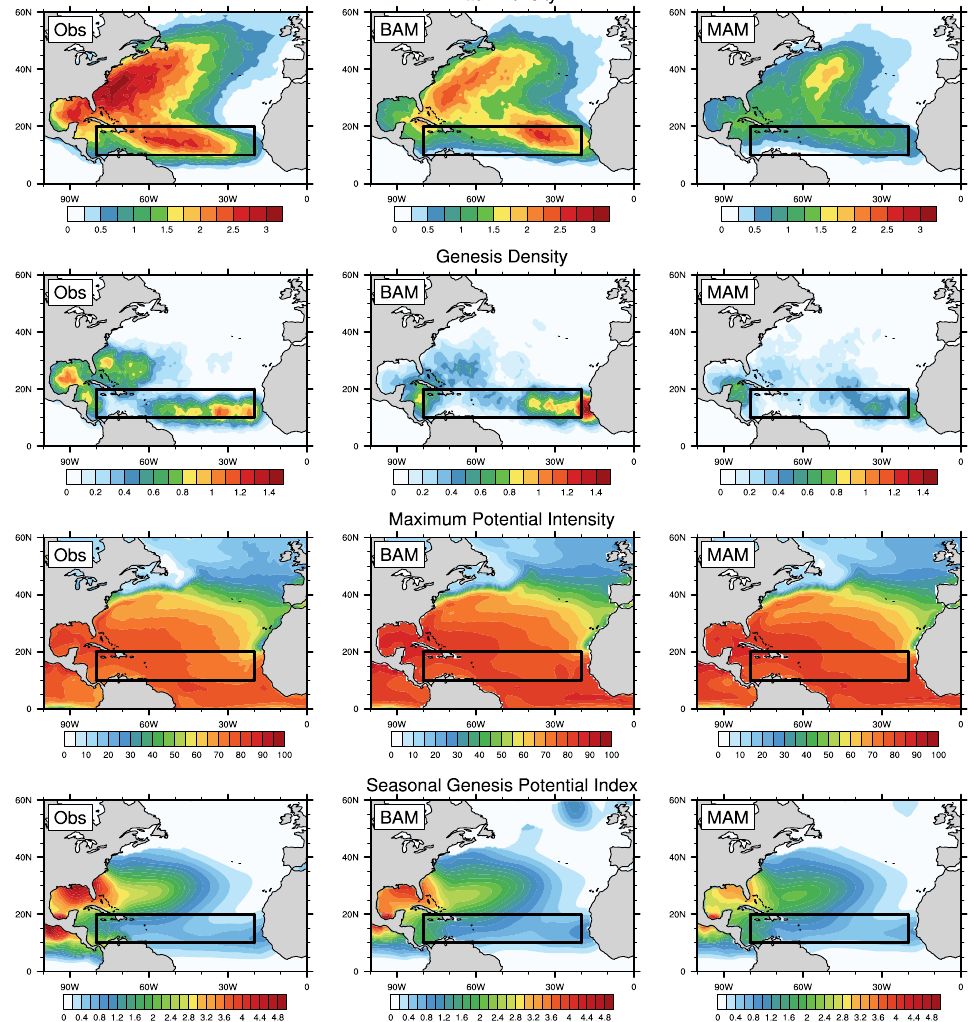
Figure 1. North Atlantic distribution of the ( first row ) seasonal track density, ( second row ) seasonal storm genesis density, ( third row ) seasonal maximum potential intensity (MPI, m/s), and ( fourth row ) seasonal average genesis potential index (GPI). These calculations are conducted for the seasonal (June–November) average from 1982 to 2005 for ( left ) observational reanalysis MERRA-2, (middle) BAM, and (right) MAM. The MDR is shown as the black outline.